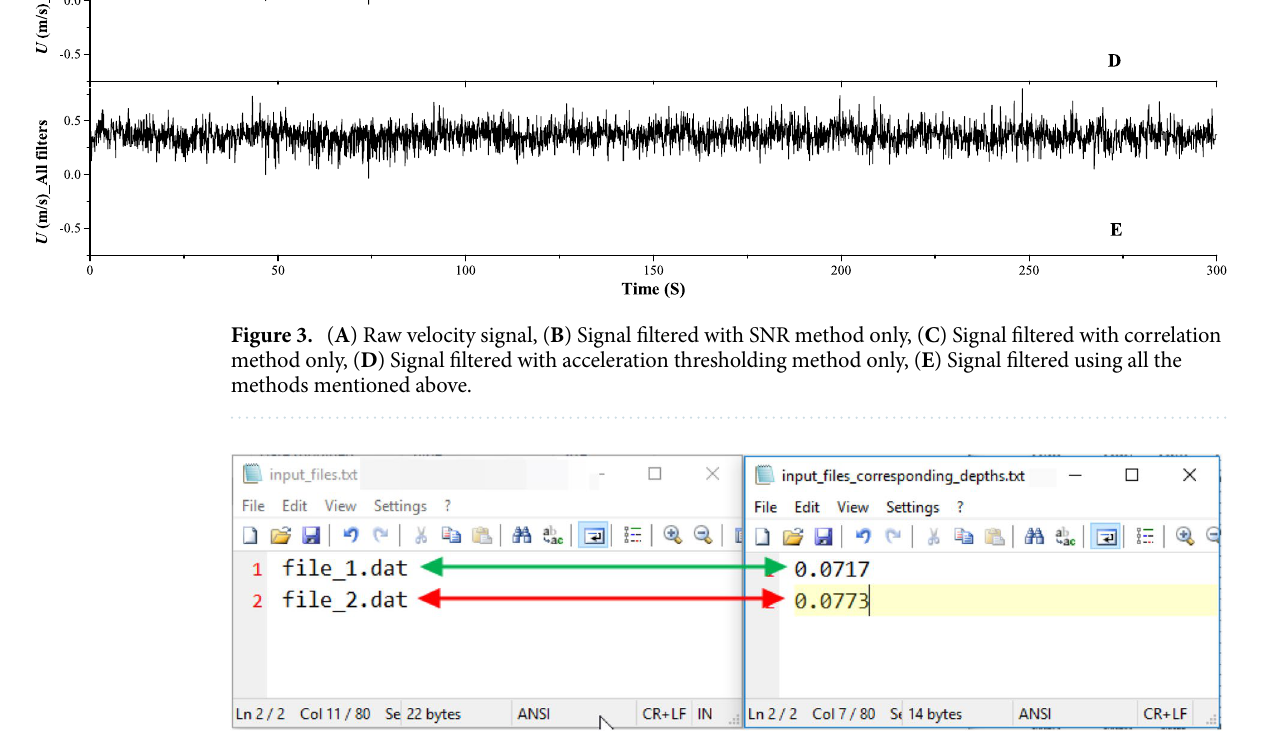
Figure 4. Mapping the filenames of input_files.txt with their corresponding depths in input_files_ corresponding_depths.txt . We see that file_1.dat has a depth of 0.0717 and file_2.dat has a depth of 0.0773.